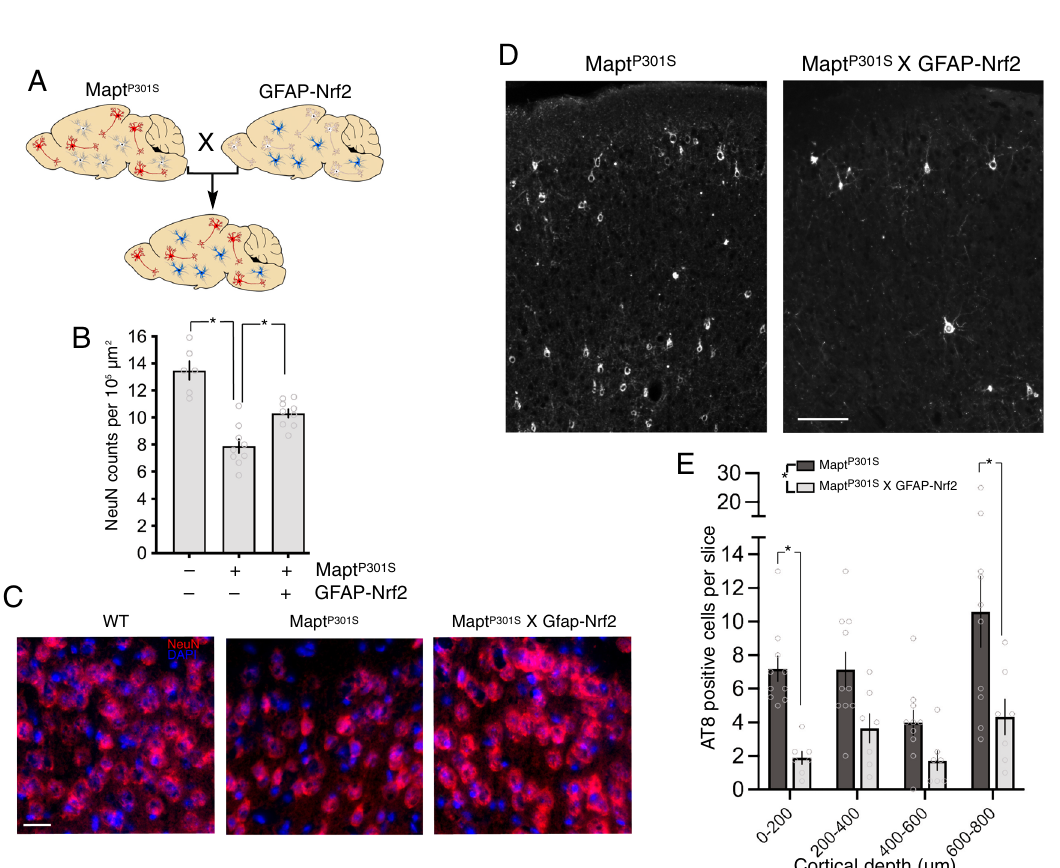
Fig. 5 Astrocytic Nrf2 reduces phospho-tau accumulation and neurodegeneration. A Schematic illustrating the crossing of MAPT P301S and GFAP-Nrf2 mice. B , C NeuN staining of upper cortical layers of mice at early-stage disease. Mean ± SEM shown. F (2, 21) = 28.83, p = 9.5E − 7 (1-way ANOVA); * Post-hoc (Bonferroni) p values: 3.8E − 07, 0.0028. N = 6 WT, 9 MAPT P301S and 9 MAPT P301S _X_GFAP-Nrf2 mice. Example pictures shown in ( C ); scale bar 20 µ m. D , E Cortical slices were subject to AT8 immuno fl uorescent staining, and positive cells counted. Mean ± SEM shown from n = 10 MAPT P301S and n = 7 MAPT P301S _X_GFAP-Nrf2 mice. Where more than one slice was analysed per mouse, and average was taken to provide a single data point per mouse. Main genotype effect: F (1, 60) = 26.54, p = 3.02E − 6 (two-way ANOVA). Post-hoc (Bonferroni) p values: 0.010, 0.0017. D Shows example pictures, scale bar 100 µ mechanisms. As expected, Aß42 levels were far lower at this early of the cortex. Similar results were seen with Aß40 (Supplementary stage, and we observed no reduction in Aß42 in either cortex or Fig. 8B). Thus crossing GFAP-Nrf2 onto the APP/PS1 line does hippocampus in Triton or SDS-soluble fractions comparing APP/ not appear to in fl uence full-length APP protein expression, nor PS1 and APP/PS1xGFAP-Nrf2 mice (Supplementary Fig. 8A), BACE1 expression or generation of the BACE-mediated pre- and a modest reduction in the level of Aß42 in the urea fraction amyloidogenic precursor APP-CTF99, and in early disease Aß